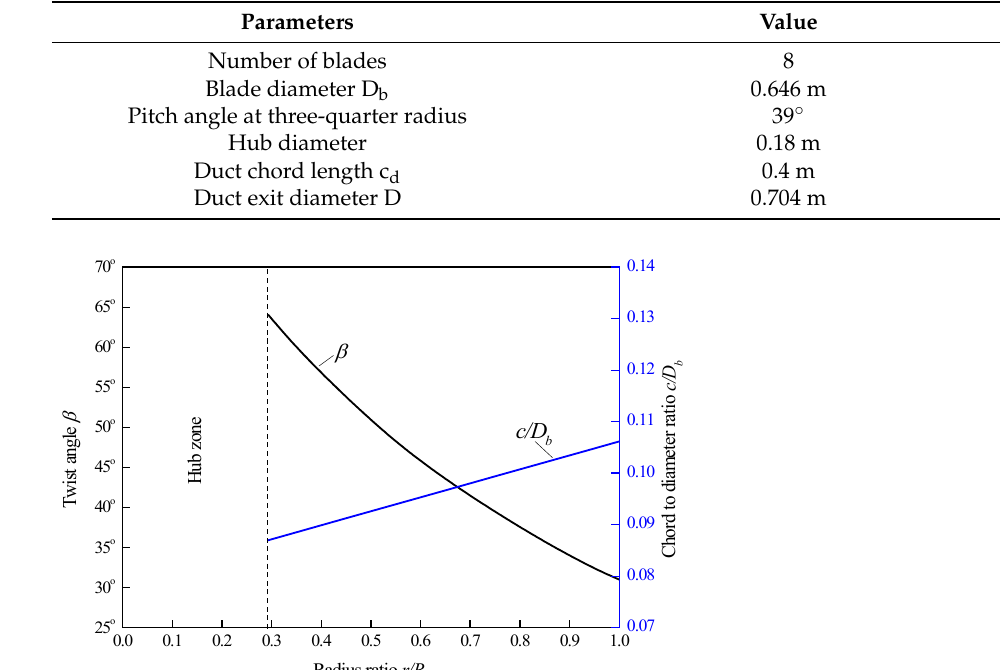
Table 1. Main parameters of the ducted fan.